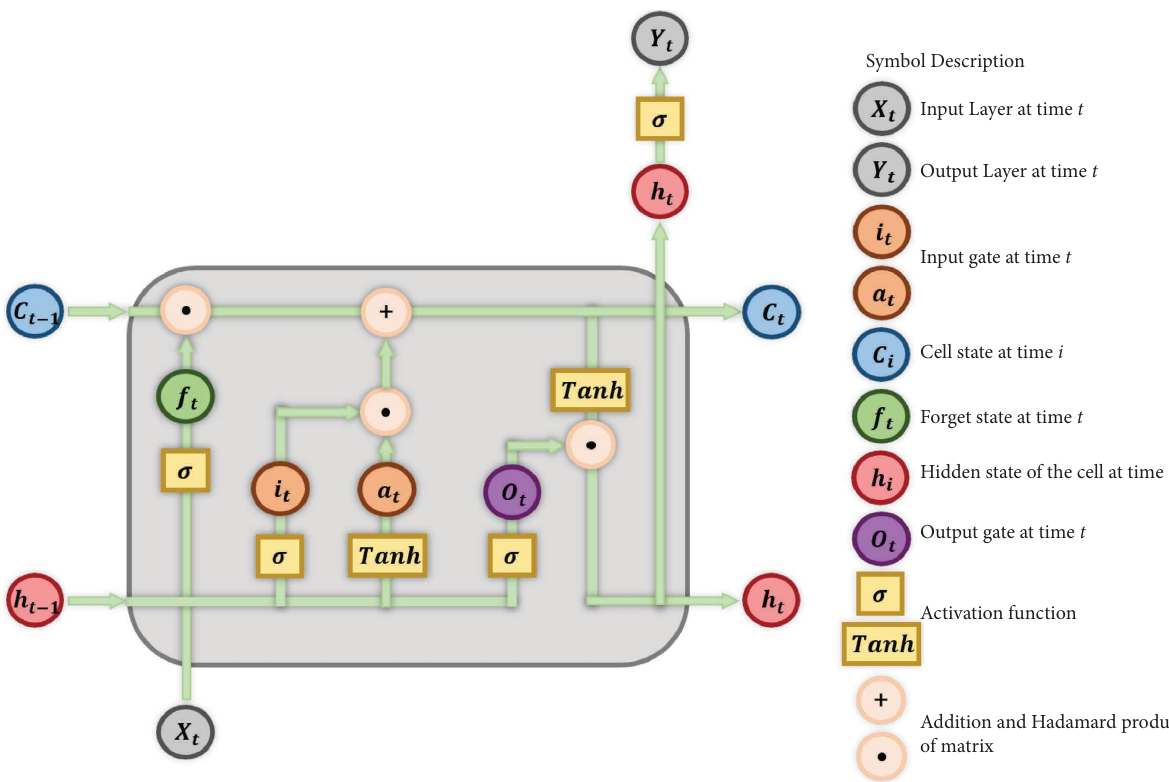
Figure 2: Te architecture of